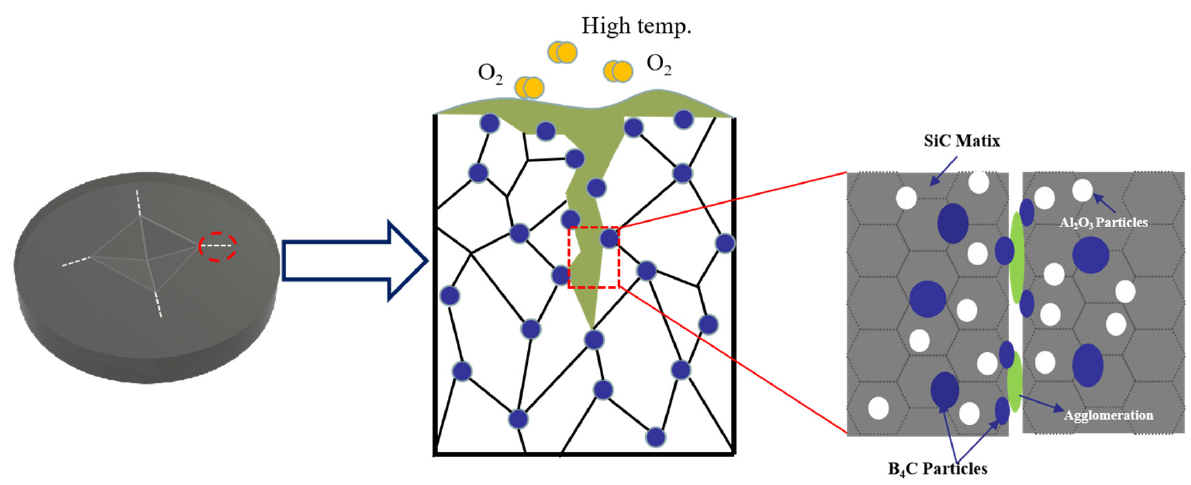
Figure 11. Healing mechanism diagram of SiC-Al 2 O 3 -B 4 C ceramic composite.